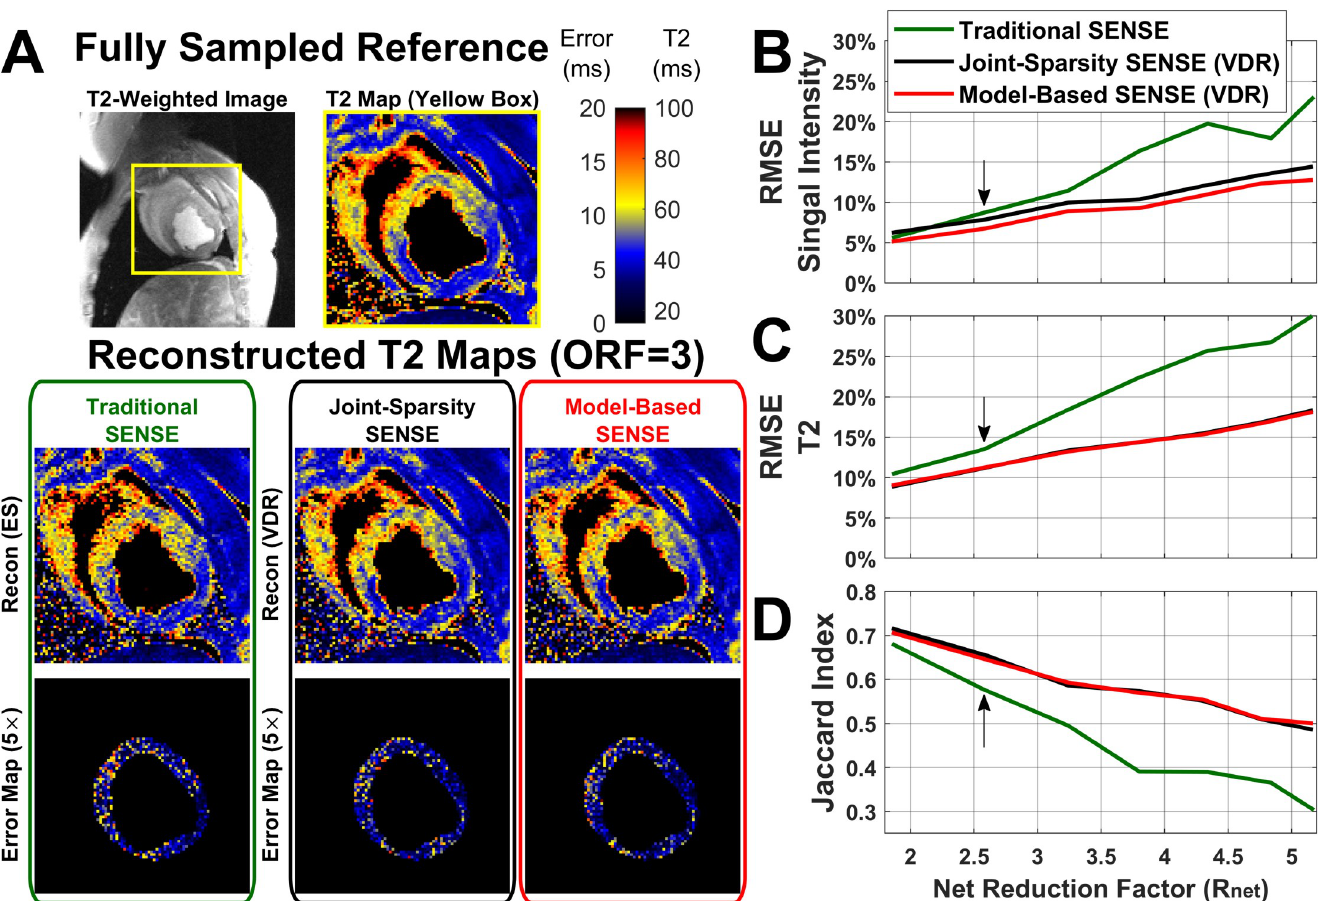
Fig 8. Results from the swine with acute myocardial infarction displaying significant edema. ( A ) Comparison of T2 maps generated with fully sampled reference, ES sampling pattern with widely available traditional SENSE reconstruction and the two best performing methods tested here: variable density random (VDR) sampling reconstructed with both joint-sparsity SENSE and model-based SENSE. ( B ) RMSE of T2 prepared images and ( C ) RMSE of T2 maps in LV increase as the net acceleration rate increase. Arrow corresponds to images shown in ( A ) using ORF = 3. These results show that though the images can support acceleration rates ORF > 3, parametric maps quickly degrade resulting in differences in the sensitivity to changes in T2. ( D ) Jaccard index, a measure of pixel-by-pixel correspondence of the segmented area with enhanced T2, decreases as the acceleration rate increases. Both joint-sparsity SENSE and model-based SENSE with VDR produce similar results and outperform traditional